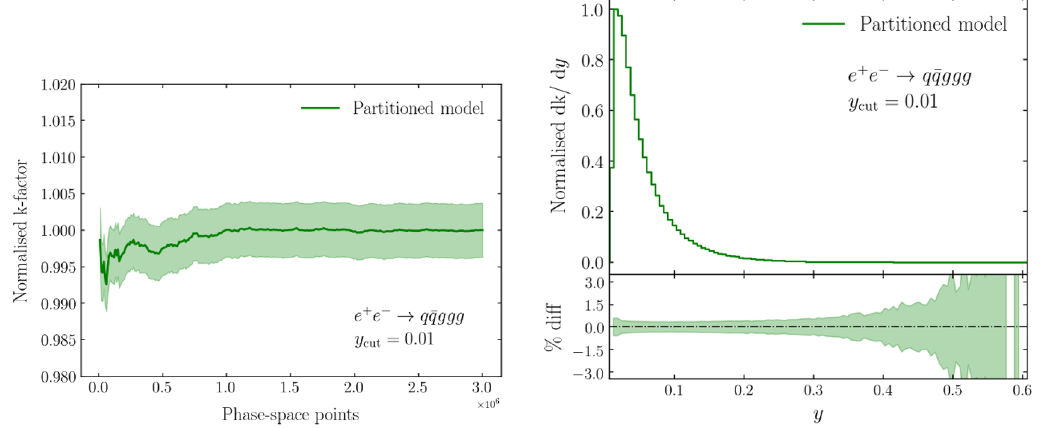
Figure 9 . Normalised NLO/LO k-factor and di(cid:11)erential k-factor against y , where y is the minimum y ij as ordered by p T , at 5 jets using just the partitioned approach. Data in the di(cid:11)erential plot is normalised to the maximum network output value. Uncertainty bands denote the following errors added in quadrature: 1 standard error from model uncertainties and Monte Carlo error on the result itself. Uncertainty bands are given as a percentage of the mean calculated over 20 trained